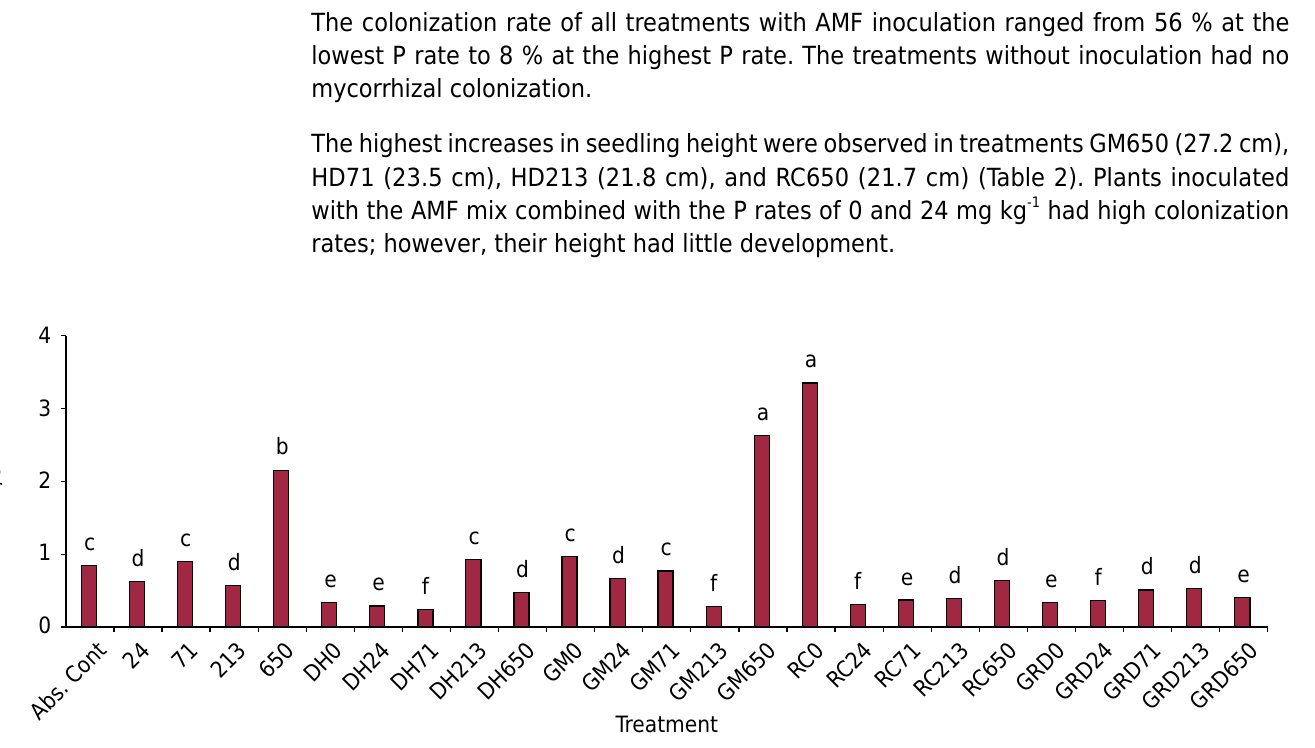
Figure 4. Comparative analysis of the ratios of RDW (root dry weight) to SDW (shoot dry weight) of Apuleia leiocarpa seedlings with the highest biomass increases due to inoculation with the AMF (arbuscular mycorrhizal fungi), Dentiscutata heterogama (DH), Gigaspora margarita (GM), Rhizophagus clarus (RC), and AMF mix of these three species (GRD) and phosphorus rates (0, 24, 71, 213, and 650 mg kg -1 ). Averages followed by different lowercase letters in the columns indicate significant difference between treatments by the Scott Knott test